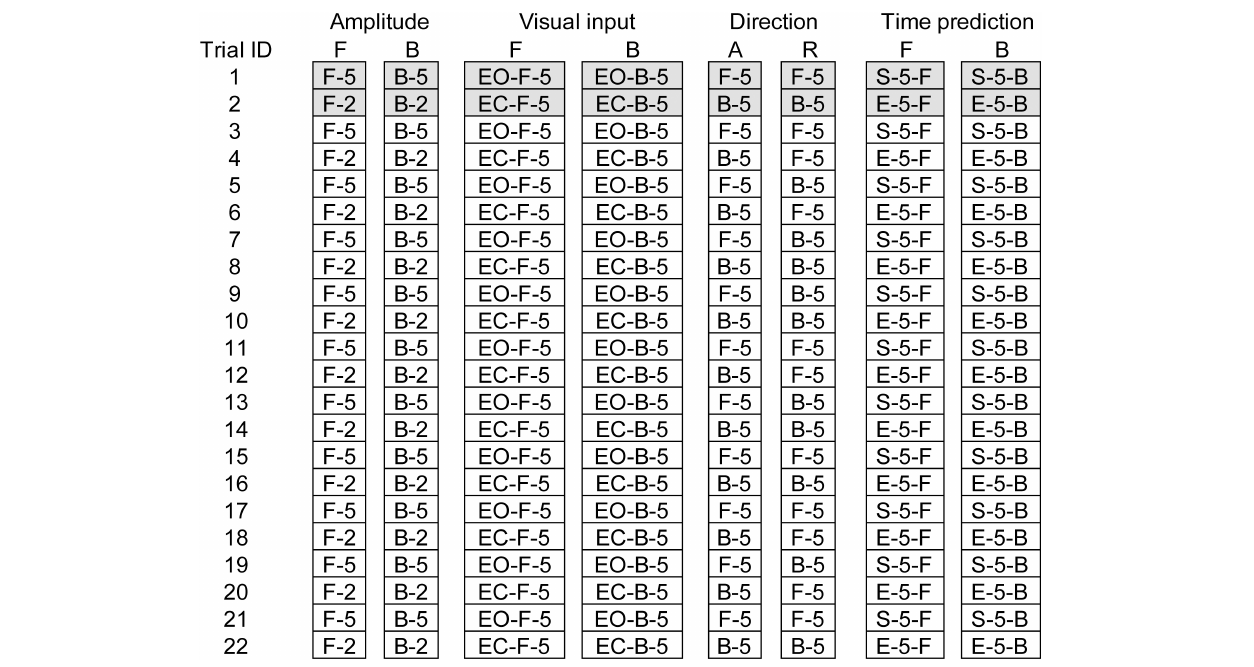
FIGURE 1 | Schedule of eight trial blocks in experiment 2. Filled cells represent trials excluded from the data analysis. A, Alternative direction; R, random direction; F, forward translation; B, backward translation; EO, eyes opened; EC, eyes closed; 2, 2 cm amplitude; 5, 5 cm